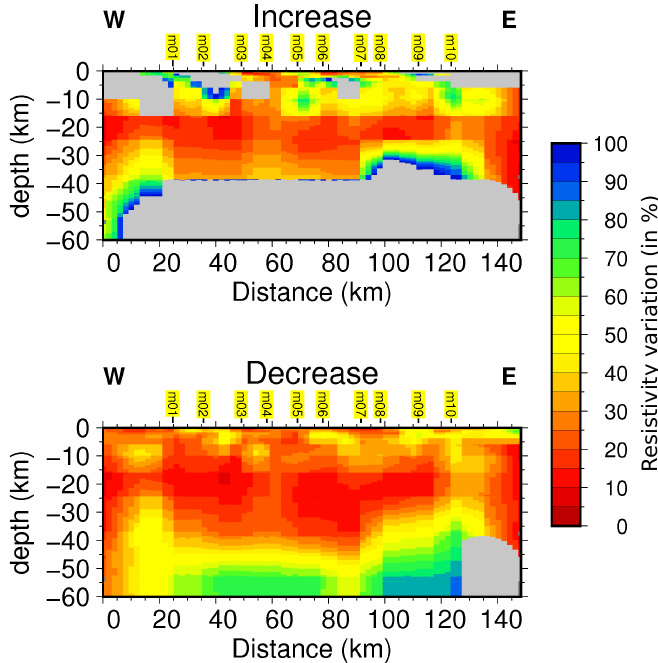
Figure A8. Results of the sensitivity analysis for the MT southern profile. On the top: increasing resistivity variations. On the bottom: decreasing variations. The grey values represent percentages greater than 100% (badly constrained values). See text for